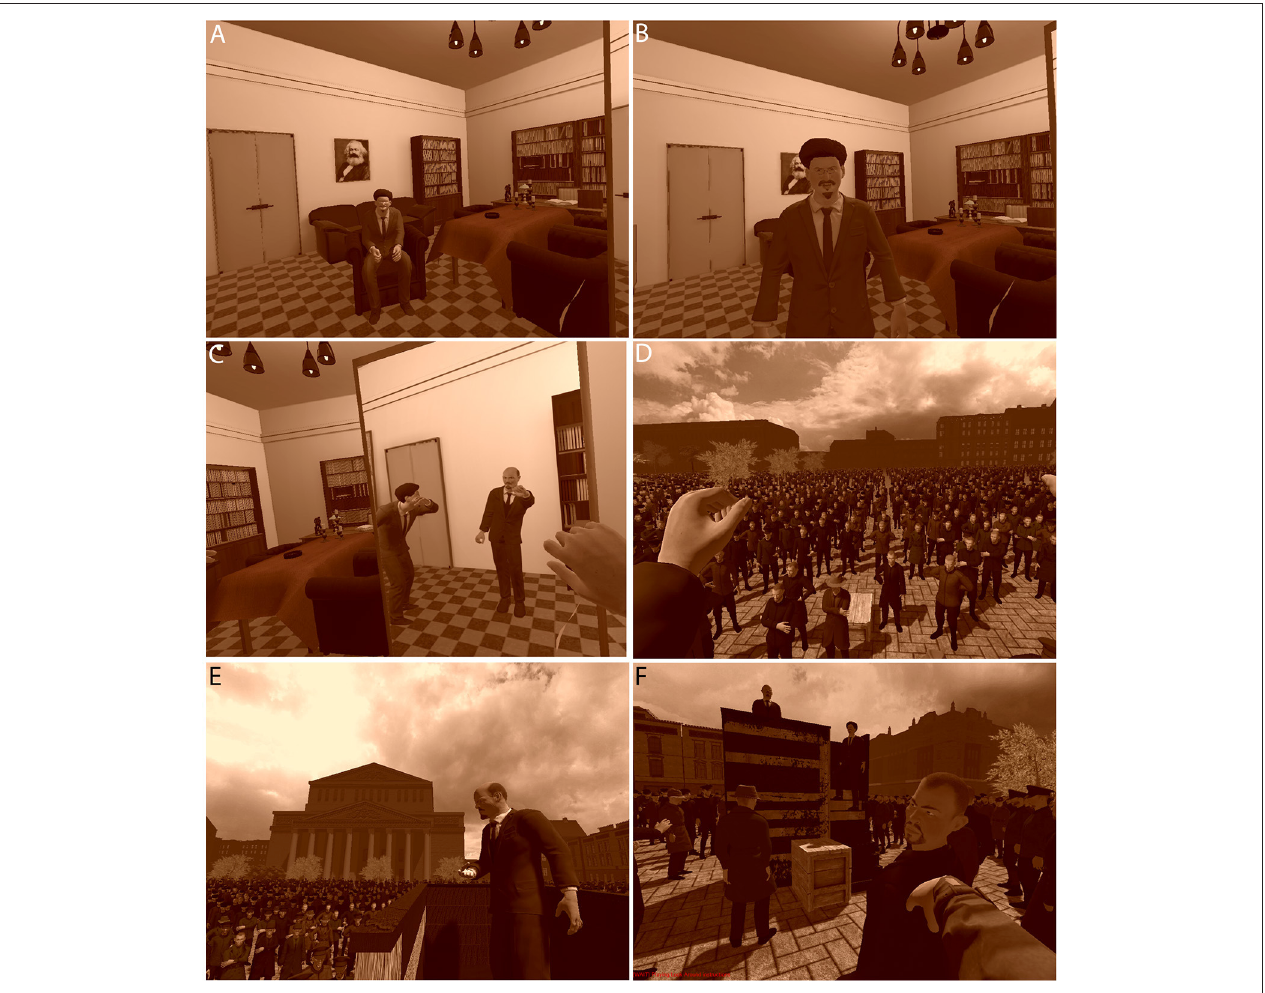
FIGURE 2 | Views of the scenario (A) Embodied as Lenin in his office, looking toward Trotsky about to stand up (B) Trotsky approaches to stand to the participant’s left (C) Trotsky is showing the participant gestures that they might make during the later speech as seen in the mirror (D) Embodied as Lenin speaking to the crowd (E) The view of Lenin giving the speech from the perspective of Trotsky (F) Viewing Lenin from the crowd—another crowd member turns to look toward the participant. age, occupation, previous VR experience, and experience with computer